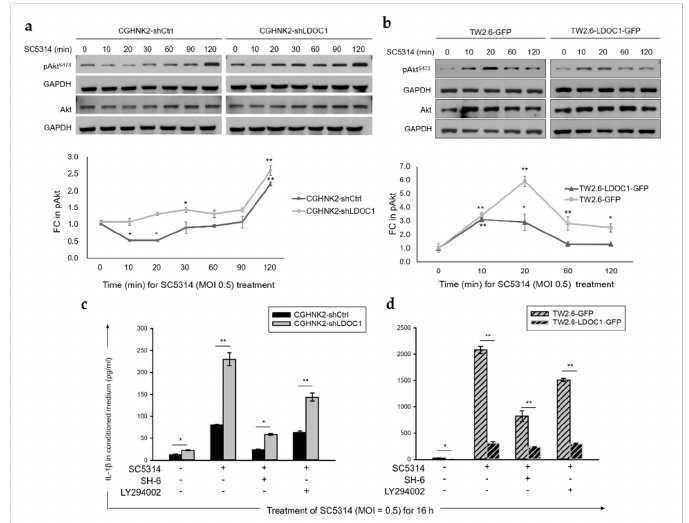
Figure 6. The PI3K/Akt signaling pathway involved in CA -induced IL-1 β production in LDOC1 - Figure 6. The PI3K / Akt signaling pathway involved in CA -induced IL-1 β production in deficient oral cells. ( a , b ) Effect of CA SC5314 on the phosphorylation of Akt S473 in LDOC1 -deficient or LDOC1 -deficient oral cells. ( a , b ) E ff ect of CA SC5314 on the phosphorylation of Akt S473 in LDOC1 -expressing oral cell lines. Cells cultured in a normal growth medium were treated with CA LDOC1 -deficient or LDOC1 -expressing oral cell lines. Cells cultured in a normal growth medium SC5314 (MOI = 0.5) for the times indicated. Equal amounts of whole-cell lysates were subjected to